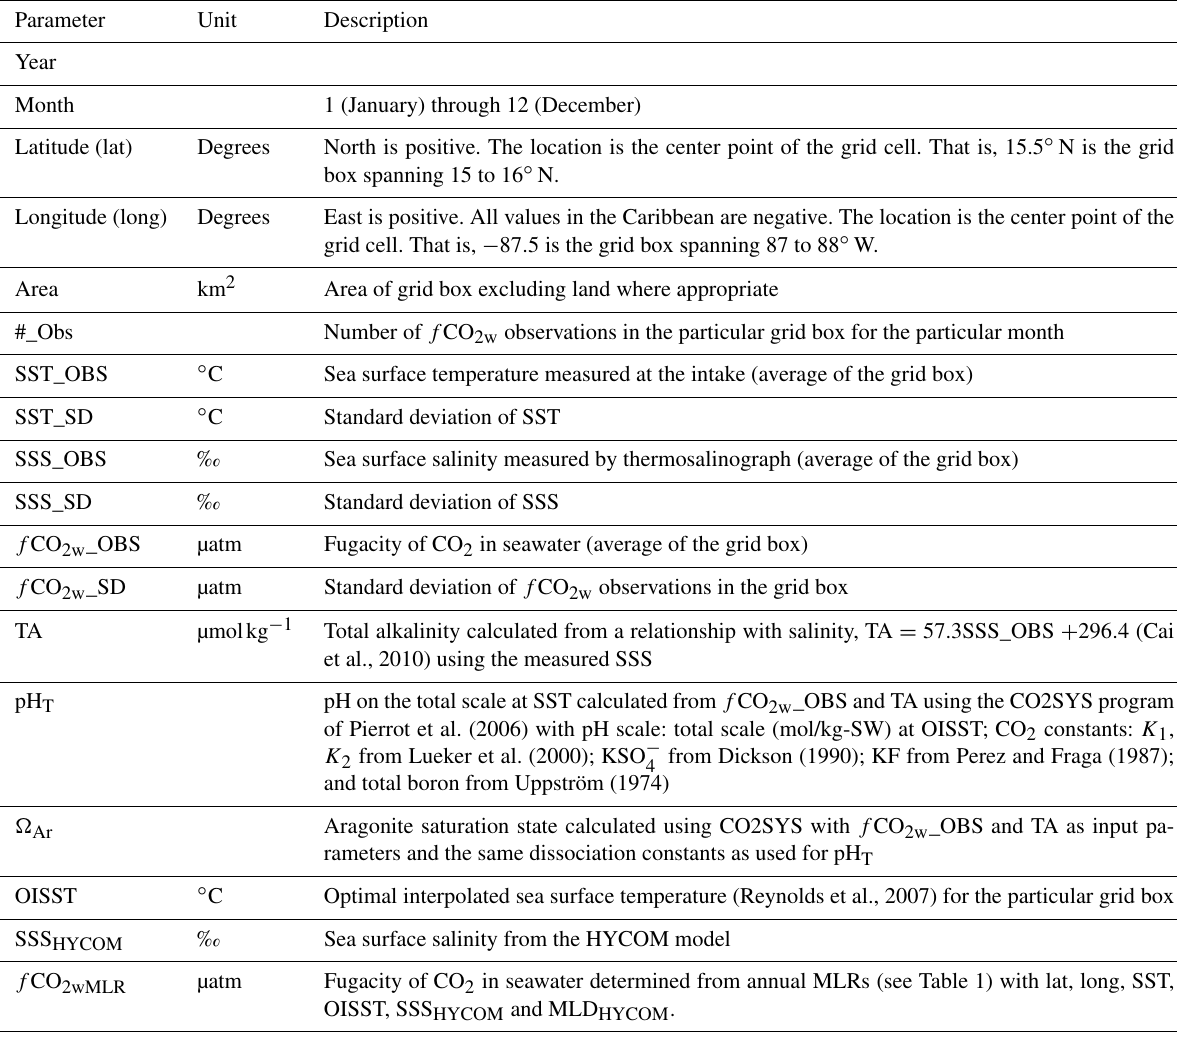
Table 3. Column headers, units and description for the monthly 1 ◦ gridded observational product (1 ◦ by 1 ◦ by month). Parameter Unit Description